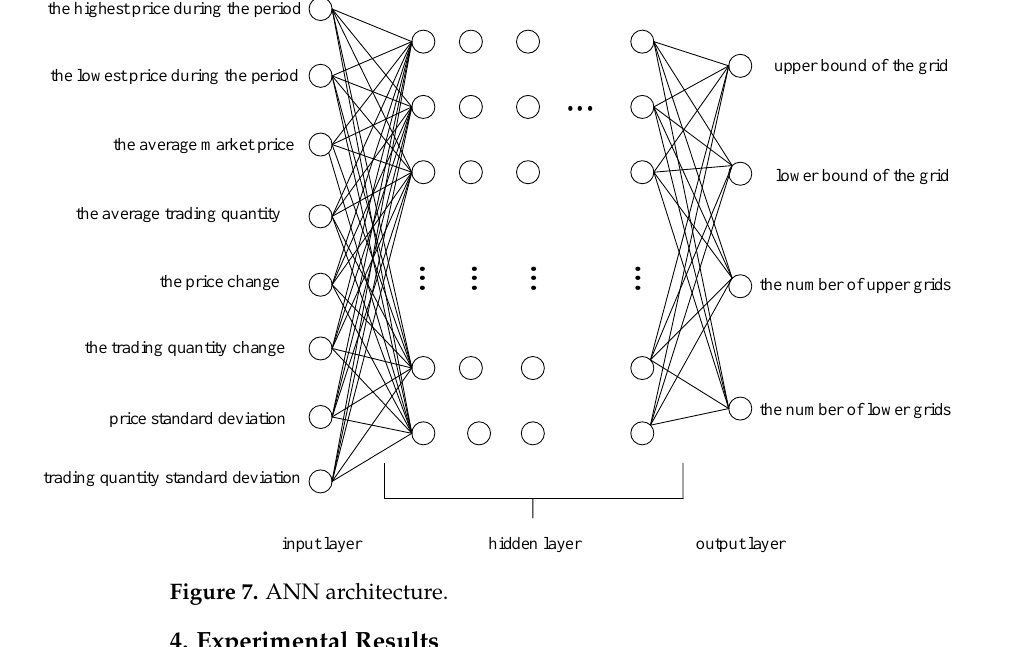
14 of 26 Table 2. Symbols and definitions of SSO. Symbols Definitions 𝑁 𝑣𝑎𝑟